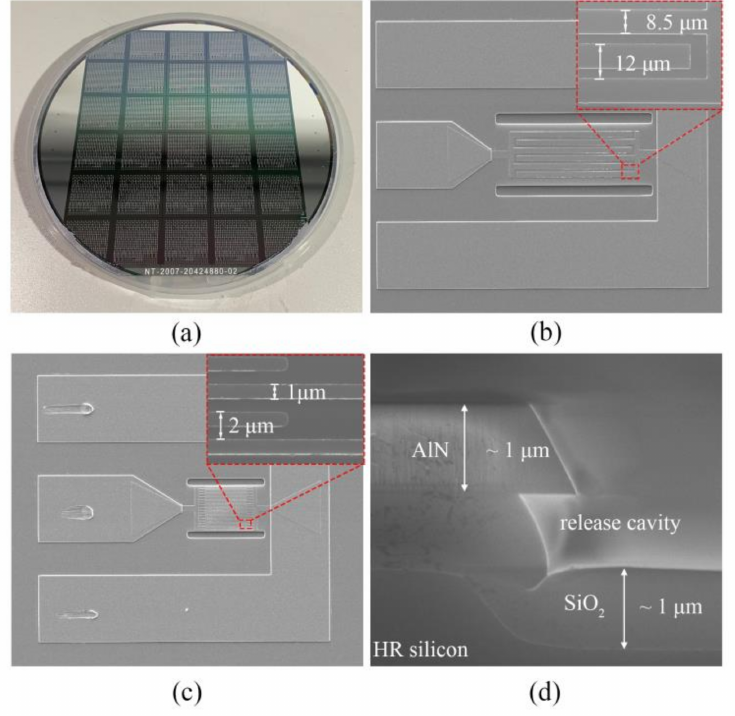
Figure 5. ( a ) The fabricated 6-inch wafer; the fabricated AlN LWRs with the IDT periods of ( b ) 12 µ m and ( c ) 2 µ m; ( d ) cross-sectional view of the device after